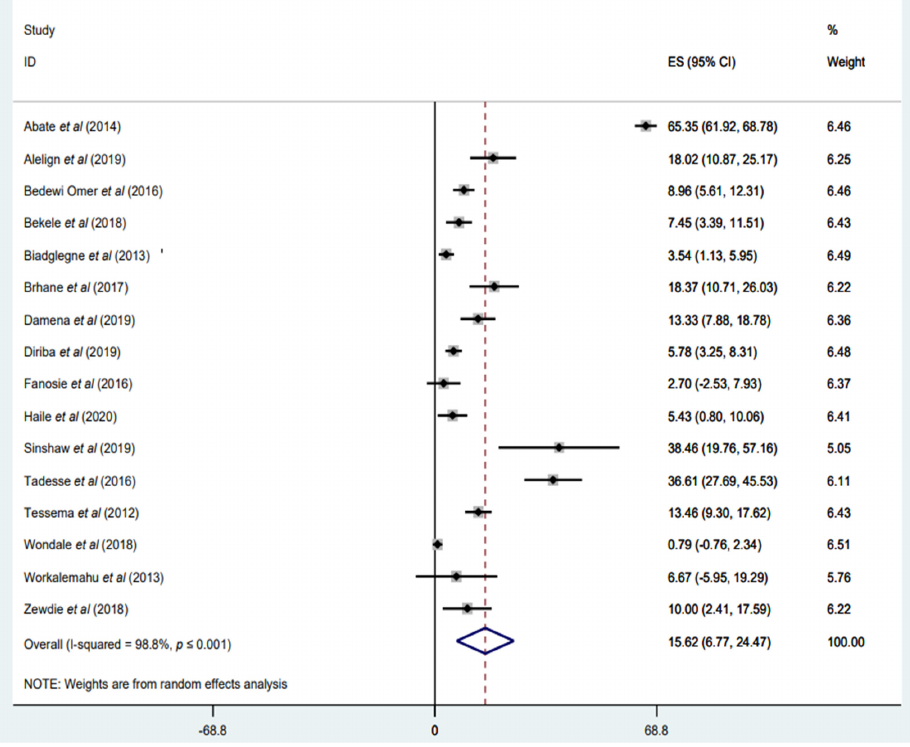
Figure 3. Forest plot showing the weighted pooled prevalence of any isoniazid (INH) resistance in tuberculosis (TB) patients.